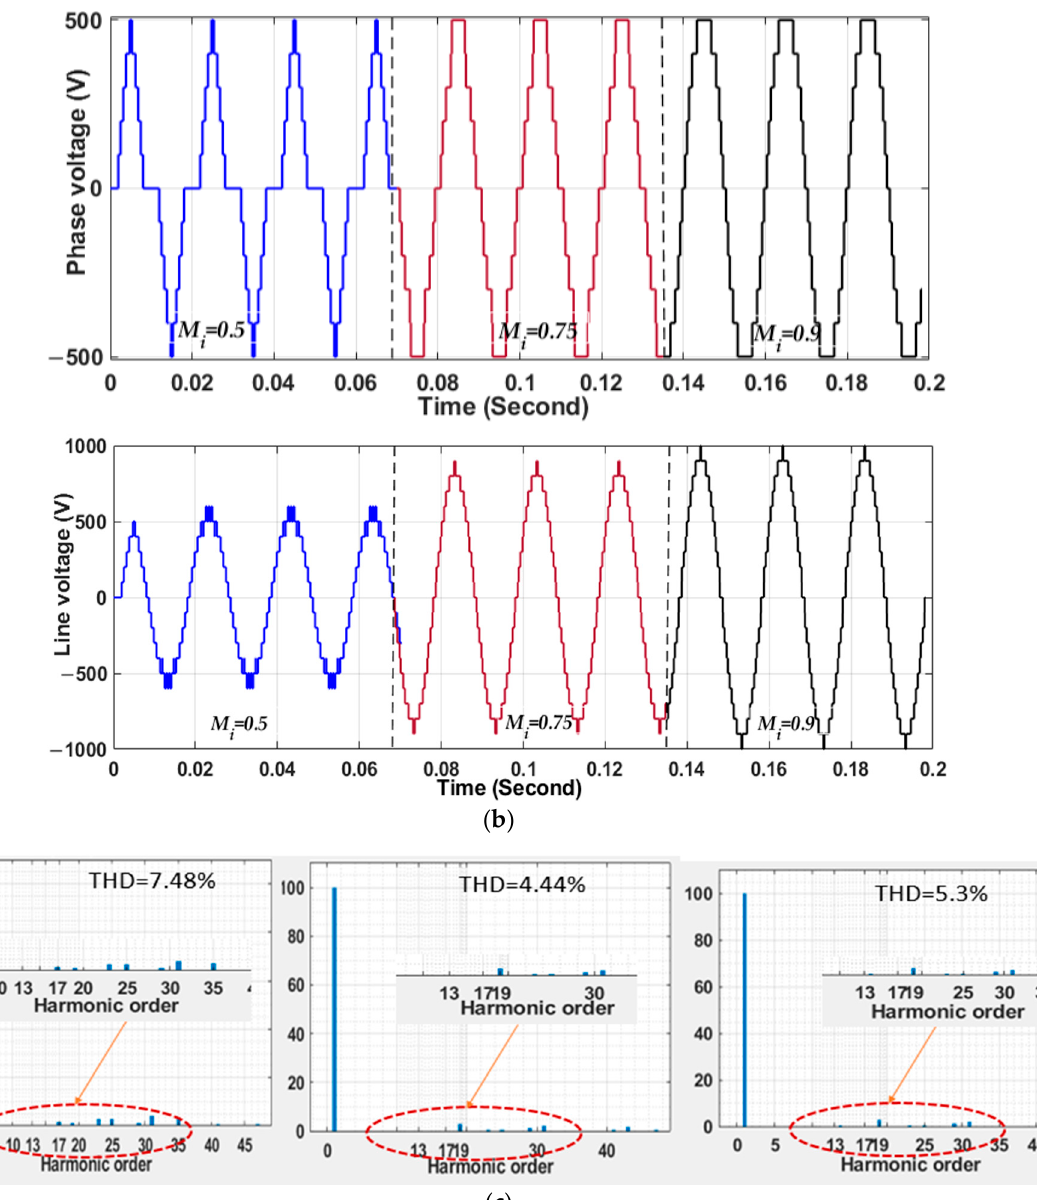
Figure 8. ( a ) Waveform of phase voltage; ( b ) Waveform of line voltage; ( c ) Spectrum analysis of line voltage at different modulation values ( M i = 0.5, 0.75, 0.9).